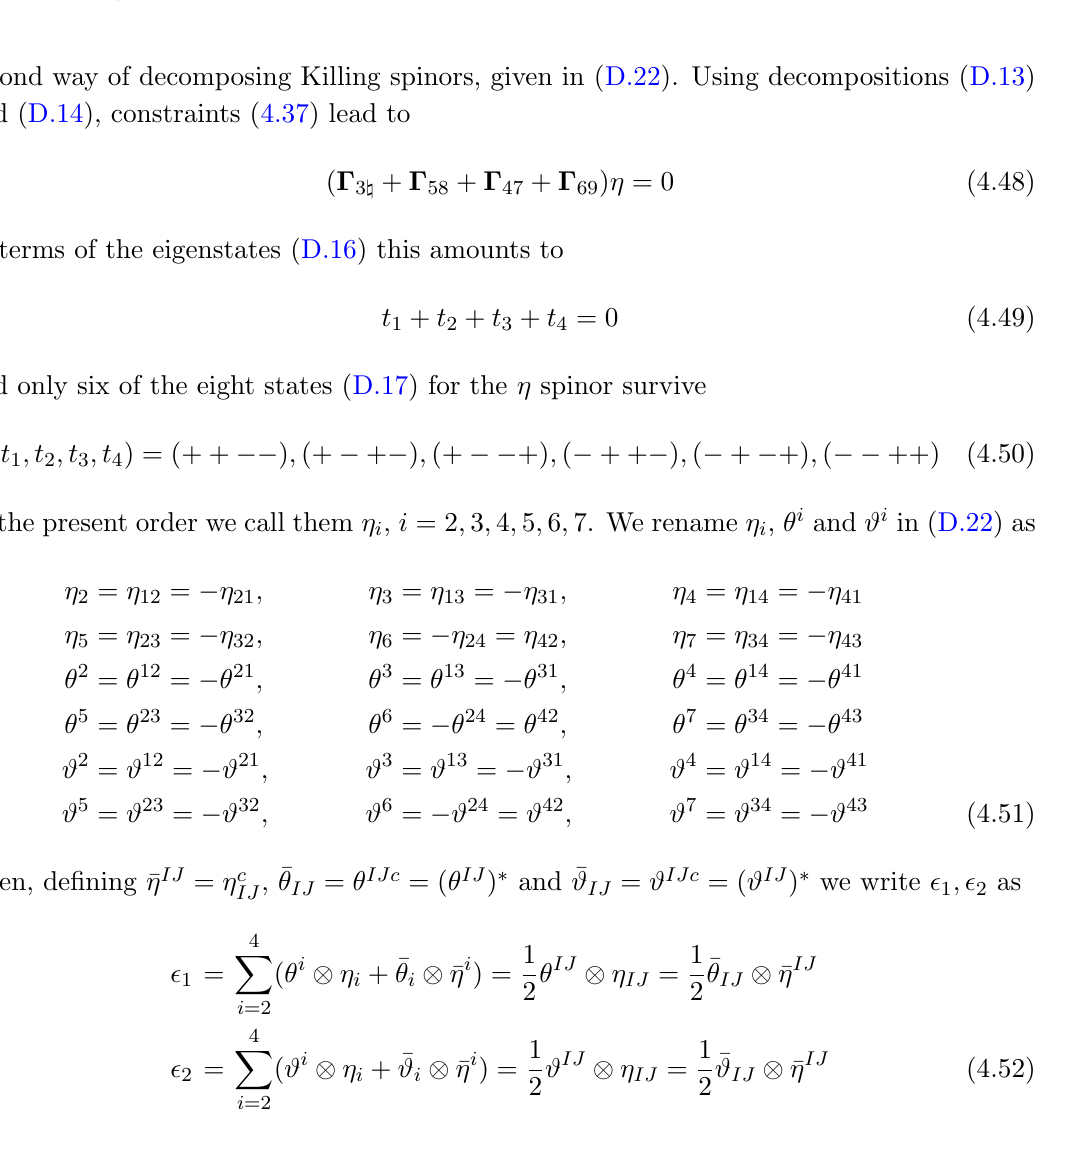
Table 3. The 1/2 BPS M2- and anti-M2-branes in AdS 4 (cid:2) S 7 = Z k spacetime, their positions, and the supercharges they